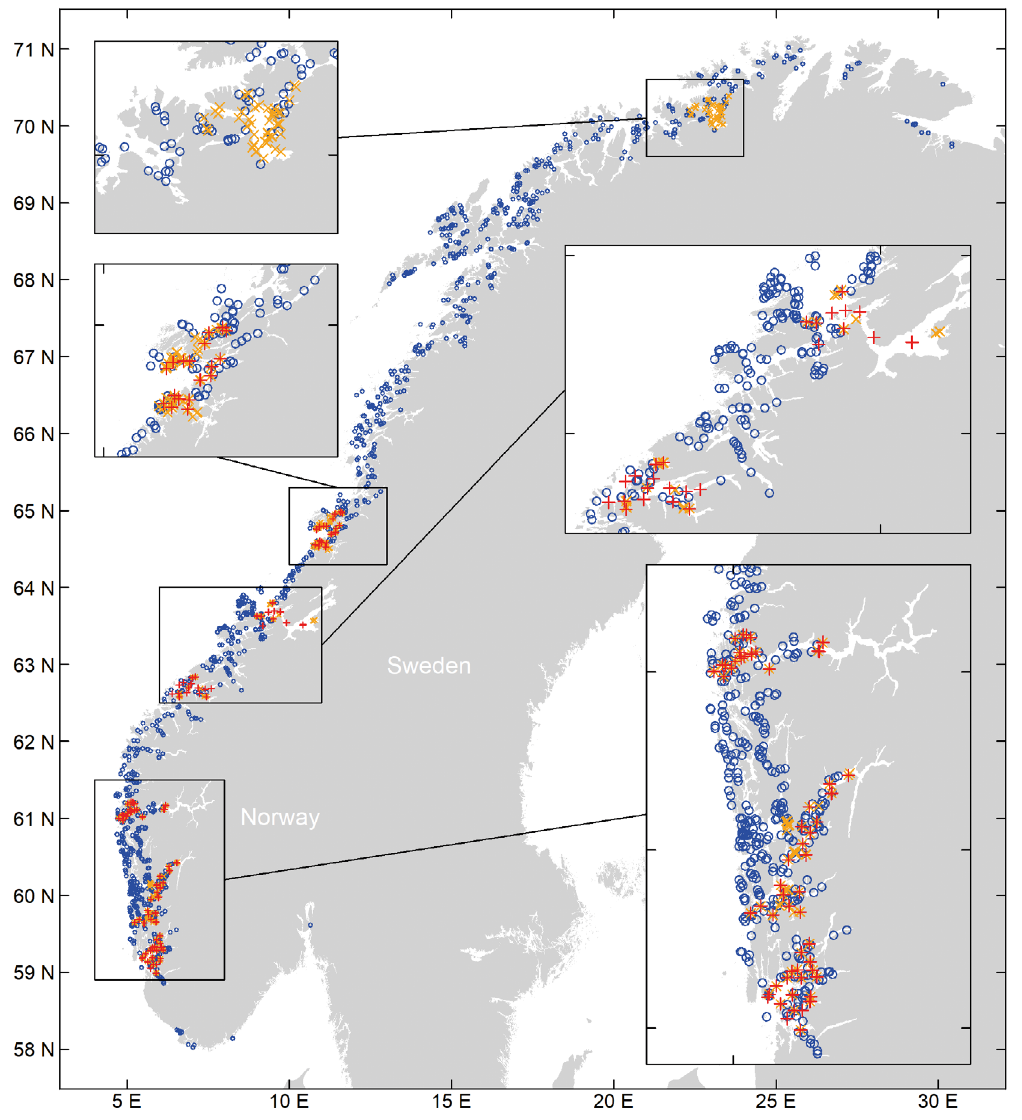
Fig. 1. Locations of sentinel cages in 2012−2017 (orange tilted crosses) and 2018−2020 (red crosses) and active salmonid farms in Norway during the study period (blue